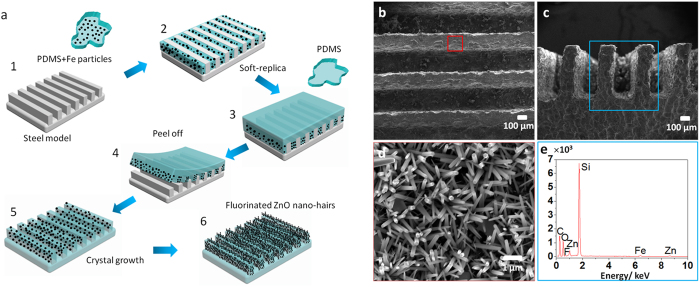
The schematic of fabrication process and the structure of DMRWs.a, The illustration of fabrication. The micro-walls of DMRW are fabricated by PDMS with Fe particles and the basement of DMRW is formed by pure PDMS (both with curing agent). After that, the DMRW is modified with ZnO nano-hairs by enhanced crystal growth method. The surface gets superhydrophobic property after being covered by FAS-17. b-c, SEM images with low magnification in the top view (b) and side view (c) of the DMRWs. Vertical flexible walls are fabricated with width of 200 μm, heights of 500 μm, and spacing of 200 μm. d, SEM image with the magnified view of DMRWs, it is covered by ZnO nano-hairs. The diameters of ZnO range from 50 nm to 80 nm. e, the EDS analysis of DMRWs, the mainly chemical constituents are C, O, F, Zn, Fe.